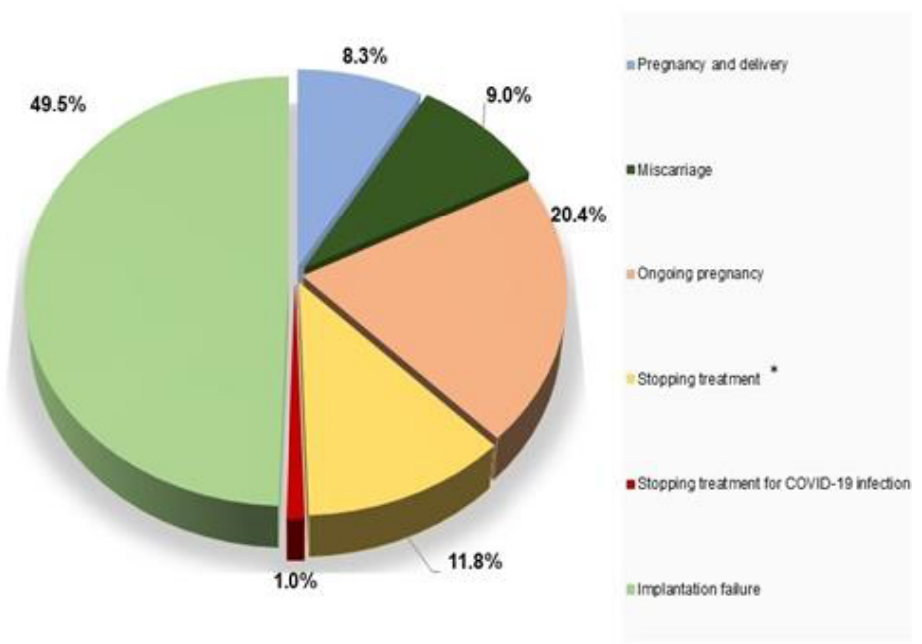
Figure 1. Percentages of obstetric and pregnancy outcomes after ART in women investigated. * Stop- ping treatment indicates that ART treatment was stopped for one of these reasons: under stimula- tion, over stimulation, no or low fertilization, delayed or abnormal embryo development. We compared the lifestyle and the emotional state in relation to the outcomes of the ART procedure, to understand the influence that these variables may have had on the ART outcomes (Figures 2–4).